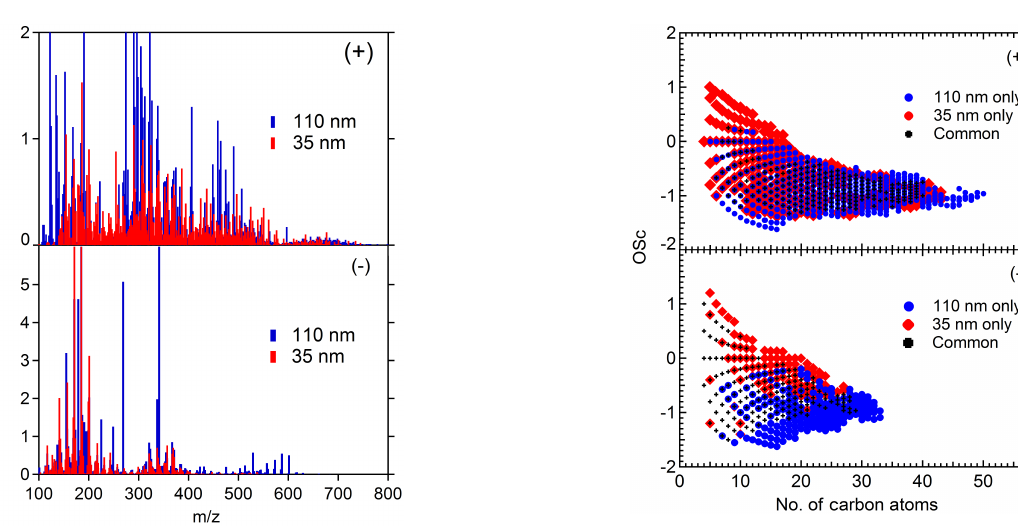
Figure 3. Positive ( + ) and negative ( − ) ion mass spectra of 35nm (red) and 110nm (blue) monodisperse SOA samples aver- aged over the five replicate experiments.